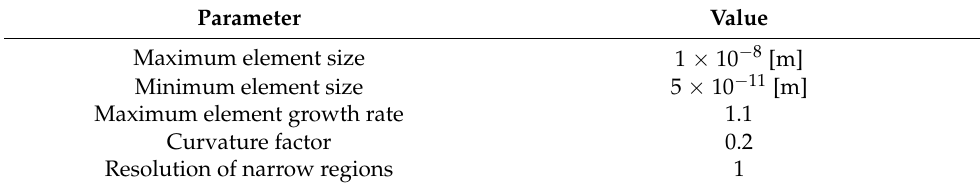
Figure 12. Schematic representation of a PIN junction on COMSOL Multiphysics®, as well as its mesh. Table 1. Mesh parameters COMSOL